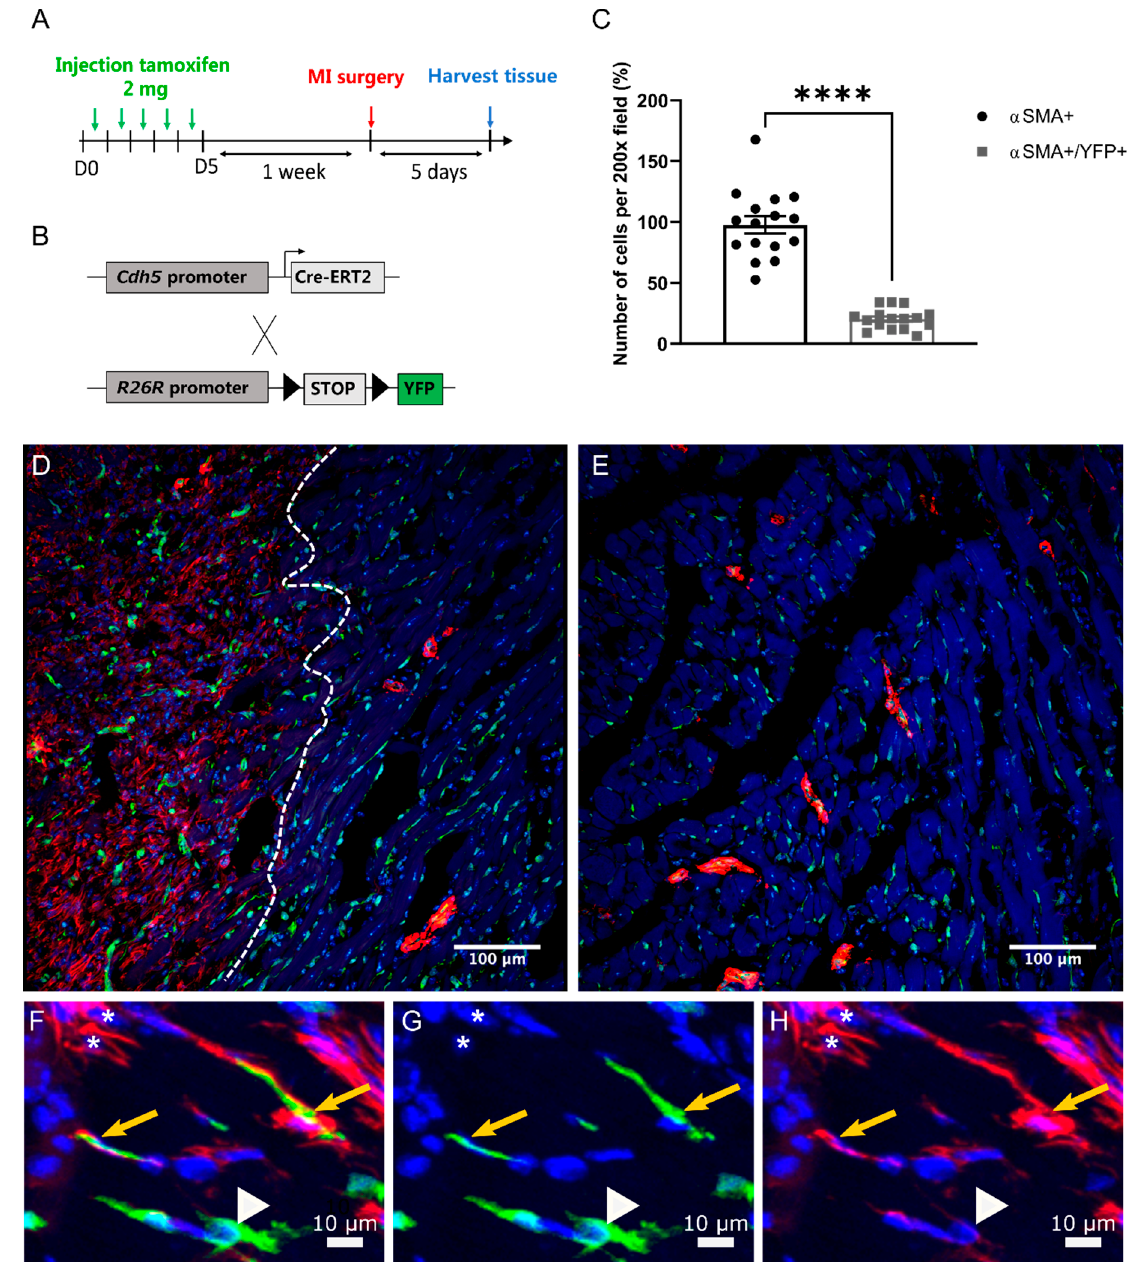
Figure 3. Endothelial-to-mesenchymal transition is present in fibrotic hearts. ( A ) Timeline for transgenic mouse heart surgery and the experiment. ( B ) Schematic representation of Cdh5-CreERT2; Rosa26R-stop-YFP mouse model. The Cdh5-CreERT2 mouse expresses the tamoxifen-activated Cre recombinase under the VE-cadherin promoter, Cdh5. Rosa26R-stop-YFP mice were crossed with inducible Cdh5-CreERT2 to permit Cre-dependent lineage tracing in endothelial cells. Transverse sections of mouse heart post-MI were stained for α SMA and YFP (endothelial cell origin). ( C ) Quantification of YFP+ α SMA+ and α SMA+ only cells from infarcted area of hearts 5 days post-MI. ( D – H ) Cdh5-Cre-ERT2;Rosa26R-stop-YFP mice underwent MI and were sacrificed 5 days later. Micrographs show an infarcted area ( D ) and a non-infarcted area ( E ). ( D ) The dotted line indicates the border between the injured (left side) and the non-injured area (right side). A higher magnification of the infarcted area is shown in the lower panel ( F , G ). YFP+ α SMA+ cells are indicated with a yellow arrow. Single YFP+ or α SMA+ cells were designated by a white arrowhead or white star respectively ( n = 4). Statistical significance was calculated by paired t -test (**** p < 0.0001).